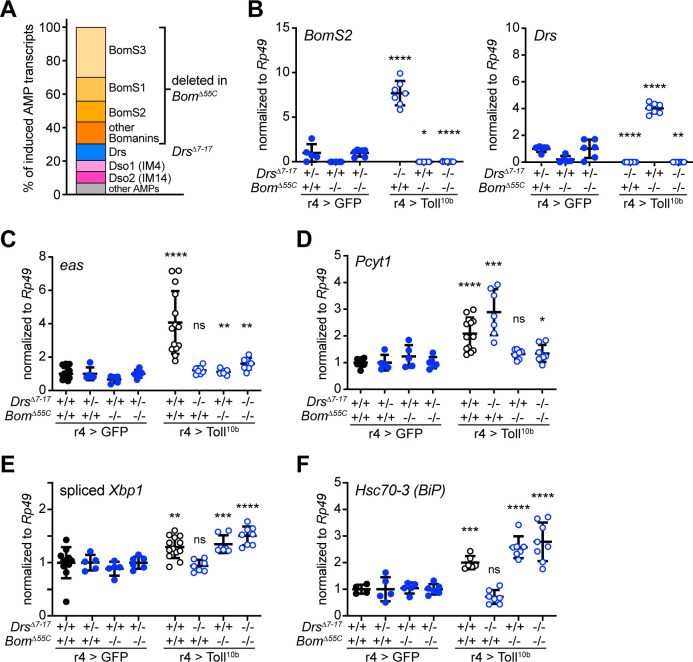
Induction of antimicrobial peptide synthesis contributes to regulation of eas and Pcyt1 by Toll signaling.(A) Toll signaling induces expression of 17 AMPs. AMPs clustered on chromosome 2 (deleted in the BomΔ55C mutant) represent 70% of the AMP transcripts induced by Toll10b expression. Drs, deleted in the DrsΔ7–17 mutant, represents 10% of the induced AMP transcripts. (B) Transcript levels of BomS2 (left) and Drs (right), normalized to Rp49, in fat bodies of late third instar larvae expressing GFP (closed symbols) or Toll10b (open symbols) under r4-GAL4 control. Animals were wild type, heterozygous, or homozygous for DrsΔ7–17 and BomΔ55C as indicated, n = 5-8/group. *p = 0.0145, **p = 0.0015, and ****p < 0.0001 versus GFP-expressing controls with the same DrsΔ7–17 and BomΔ55C genotypes. Note that GFP-expressing controls are heterozygous for DrsΔ7–17 while Toll10b-expressing larvae are homozygous for DrsΔ7–17. (C, D) Transcript levels of eas (C) and Pcyt1 (D), normalized to Rp49, in fat bodies of late third instar larvae expressing GFP (closed symbols) or Toll10b (open symbols) under r4-GAL4 control. Animals were wild type, heterozygous, or homozygous for DrsΔ7–17 and BomΔ55C as indicated, n = 5-8/group (blue open and closed symbols) and n = 11-14/group for animals expressing GFP or Toll10b in fat body on a wild type background (black open and closed symbols). *p ≤ 0.0409, **p ≤ 0.032, ***p = 0.0009, and ****p < 0.0001. (E, F) Transcript levels of spliced Xbp1 (E) and Hsc70-3 (BiP) (F), normalized to Rp49, in fat bodies of late third instar larvae expressing GFP (closed symbols) or Toll10b (open symbols) under r4-GAL4 control. Animals were wild type, heterozygous, or homozygous for DrsΔ7–17 and BomΔ55C as indicated, n = 5-8/group (blue open and closed symbols), n = 11-13/group (spliced Xbp1), and n = 4-6/group (Hsc70-3 (BiP)) for animals expressing GFP or Toll10b in fat body on a wild type background (black open and closed symbols). **p = 0.0086, ***p = 0.0004, and ****p < 0.0001. Data are presented as means ± SD. p values were determined by Student’s t test.